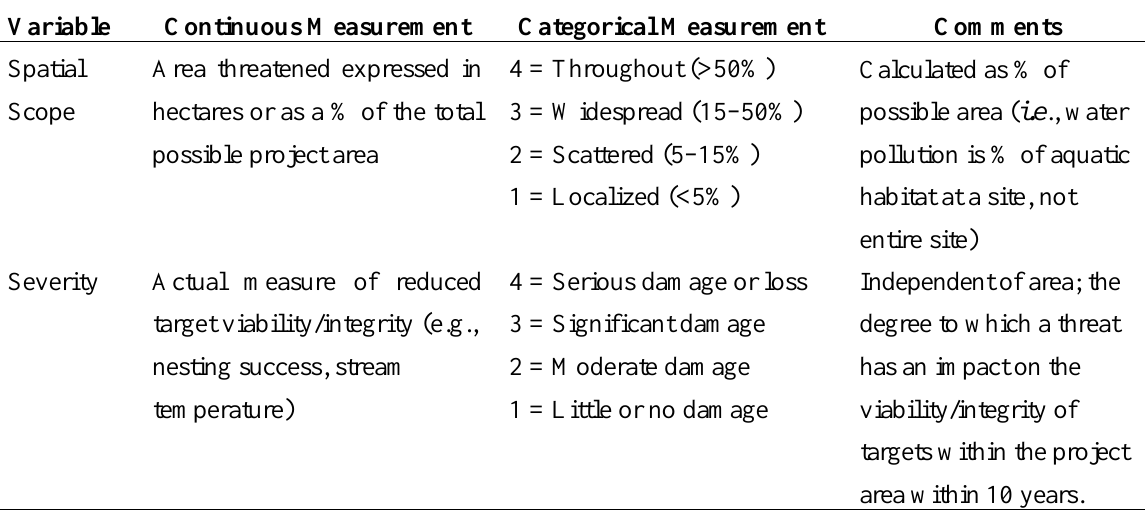
Table 5. Numeric scores (categorical measurement) given to each factors that influence habitats identified for each SWReGAP habitat type in New Mexico. Scores and definitions from Salafsky et al . [16] and The Nature Conservancy